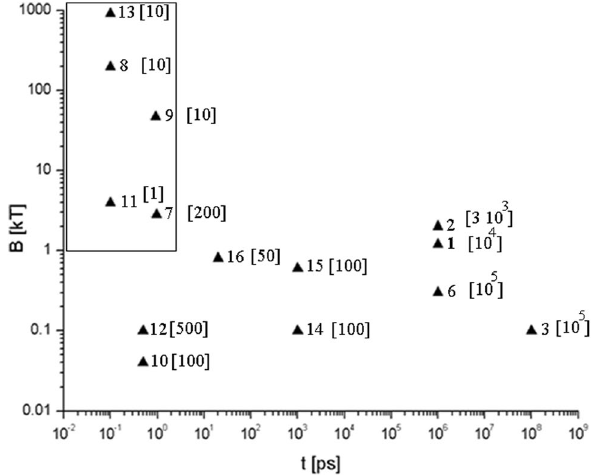
Figure 1. Maximum amplitude of magnetic fields (the number of the triangle is the number in the reference list) its characteristic spatial distribution (in brackets, in μm) and lifetimes obtained recently in real and numerical experiments. The rectangular area corresponds to the range of parameters of the magnetic field generated by the laser cluster plasma studied in our